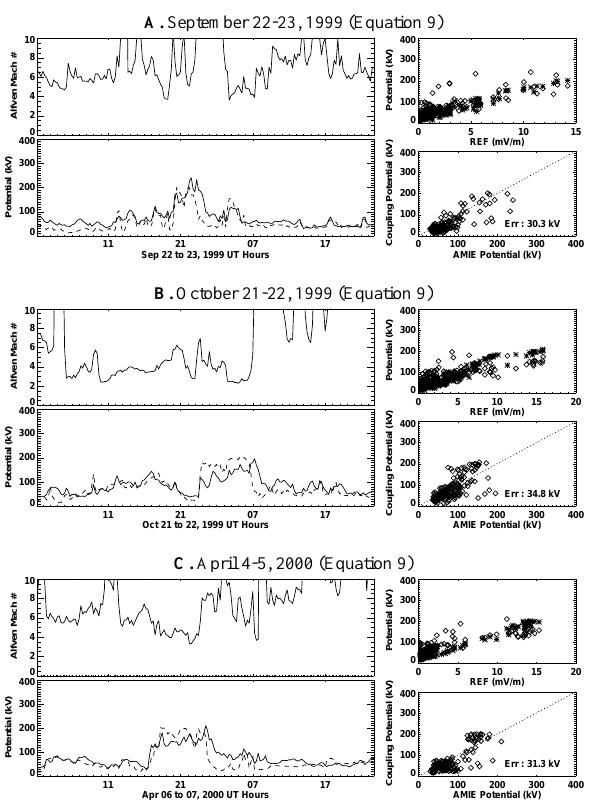
Fig. 12. The same three events in Figure 2, plotted in the same way as Figure 11. Fig. 11. The same three events in Figure 1, plotted in the same way, except Equation 9 was used rather than estimating the CPCP with Boyle et al. (1997). The top plot is the Alfv´en Mach number. When the solar wind number density is 25 cm − 3 , the solar wind becomes sub-Alfv´enic only when the IMF is larger than 90 nT, which is a very rare occurrence. When one considers that the cores of magnetic clouds are regions of high mag- netic field strength, low temperature, and low density, they are in the exact region that can easily become sub-Alfv´enic. 36